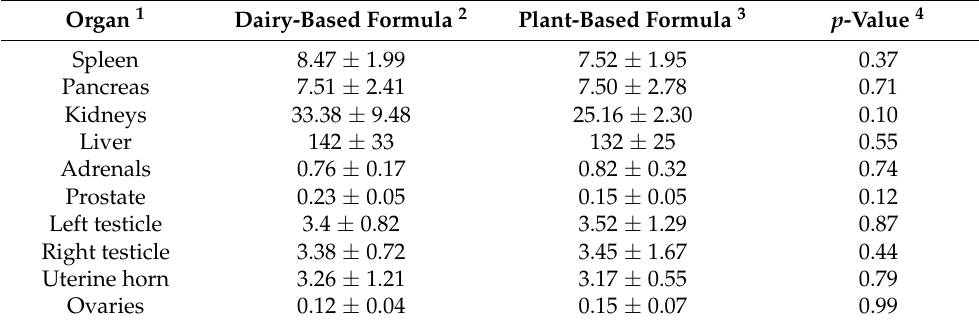
Table 2. Organ weights (g) of neonatal piglets at 21 days of age fed either a dairy-based or a plant-based formula. Data are presented as mean ± standard deviation (SD).